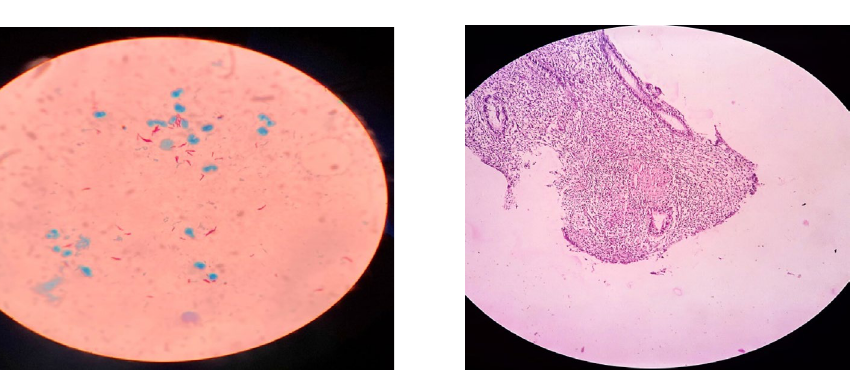
image 2. Showing Acid fast bacilli in ZN Stained smear. image 3. Showing granuloma in H&E stained